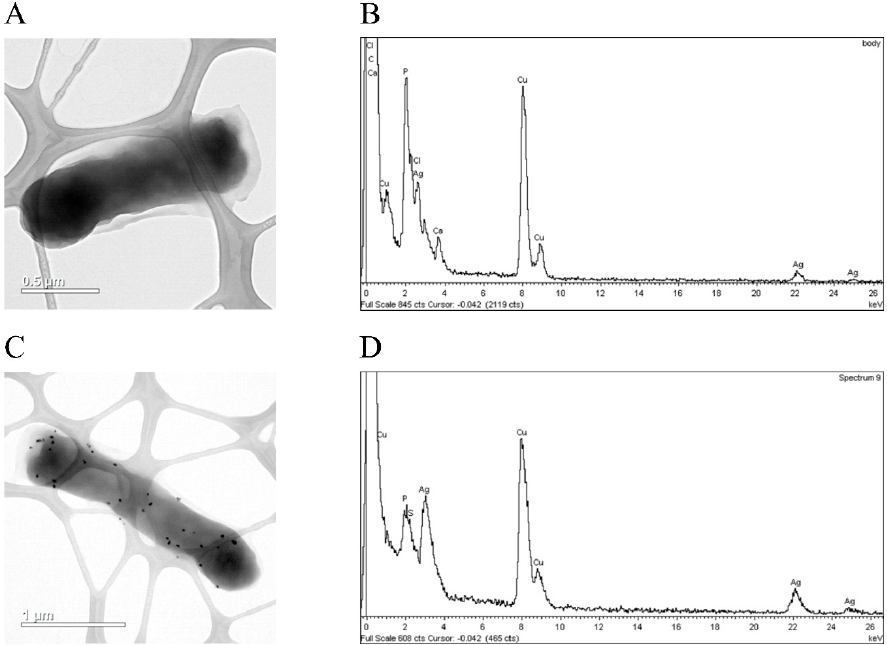
Figure 6. ( A ) TEM images of typical E. coli cell expressing GST treated with silver nitrate and ( B ) characteristic EDS spectrum of these bacteria. ( C ) A cell of the same strain, with formed silver nanoparticles (SNP) and ( D ) the characteristic EDS spectrum for cells expressing GST and forming SNP-like